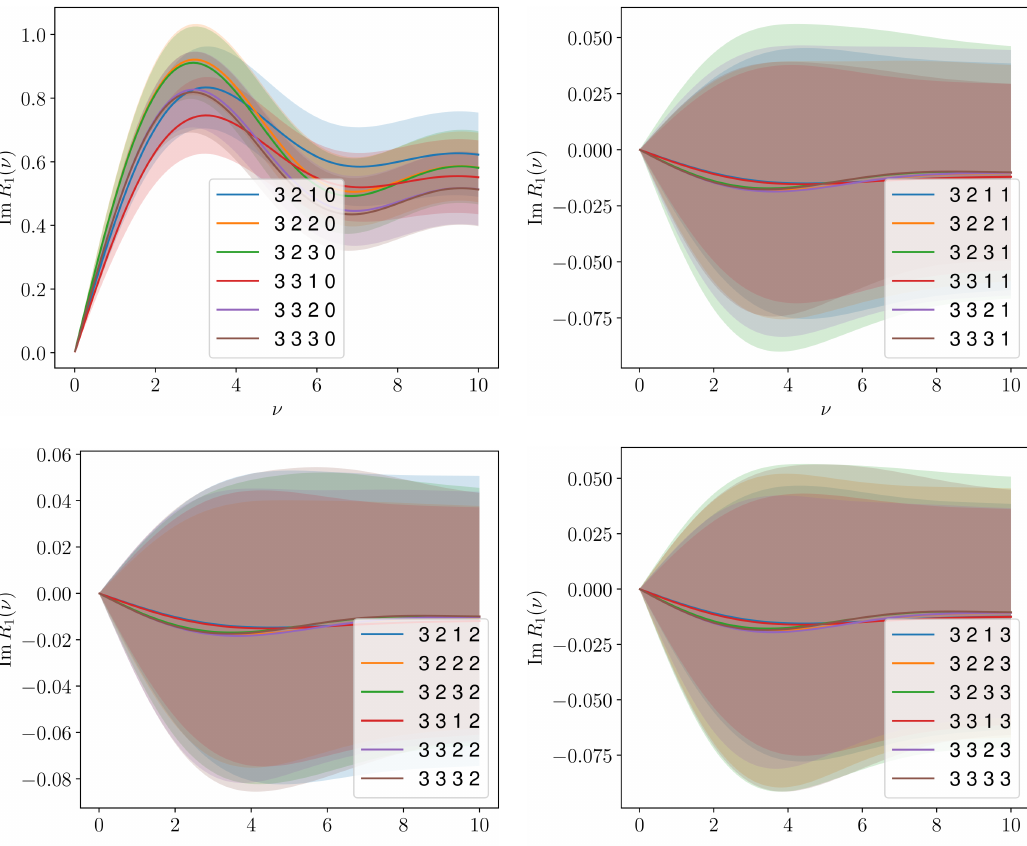
Figure 27 . The higher twist term, B 1 , results from fitting the imaginary component to the models. The numbers in the legend correspond to ( N ± , N